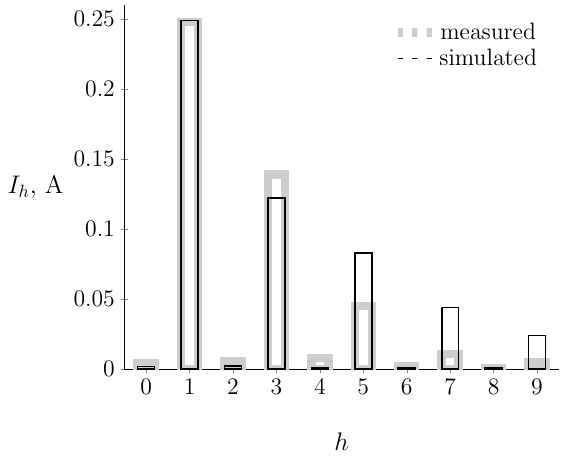
Figure 14. Summary of the harmonic content in the transformer no-load current at 233V supplied voltage for measured and simulated waveforms.